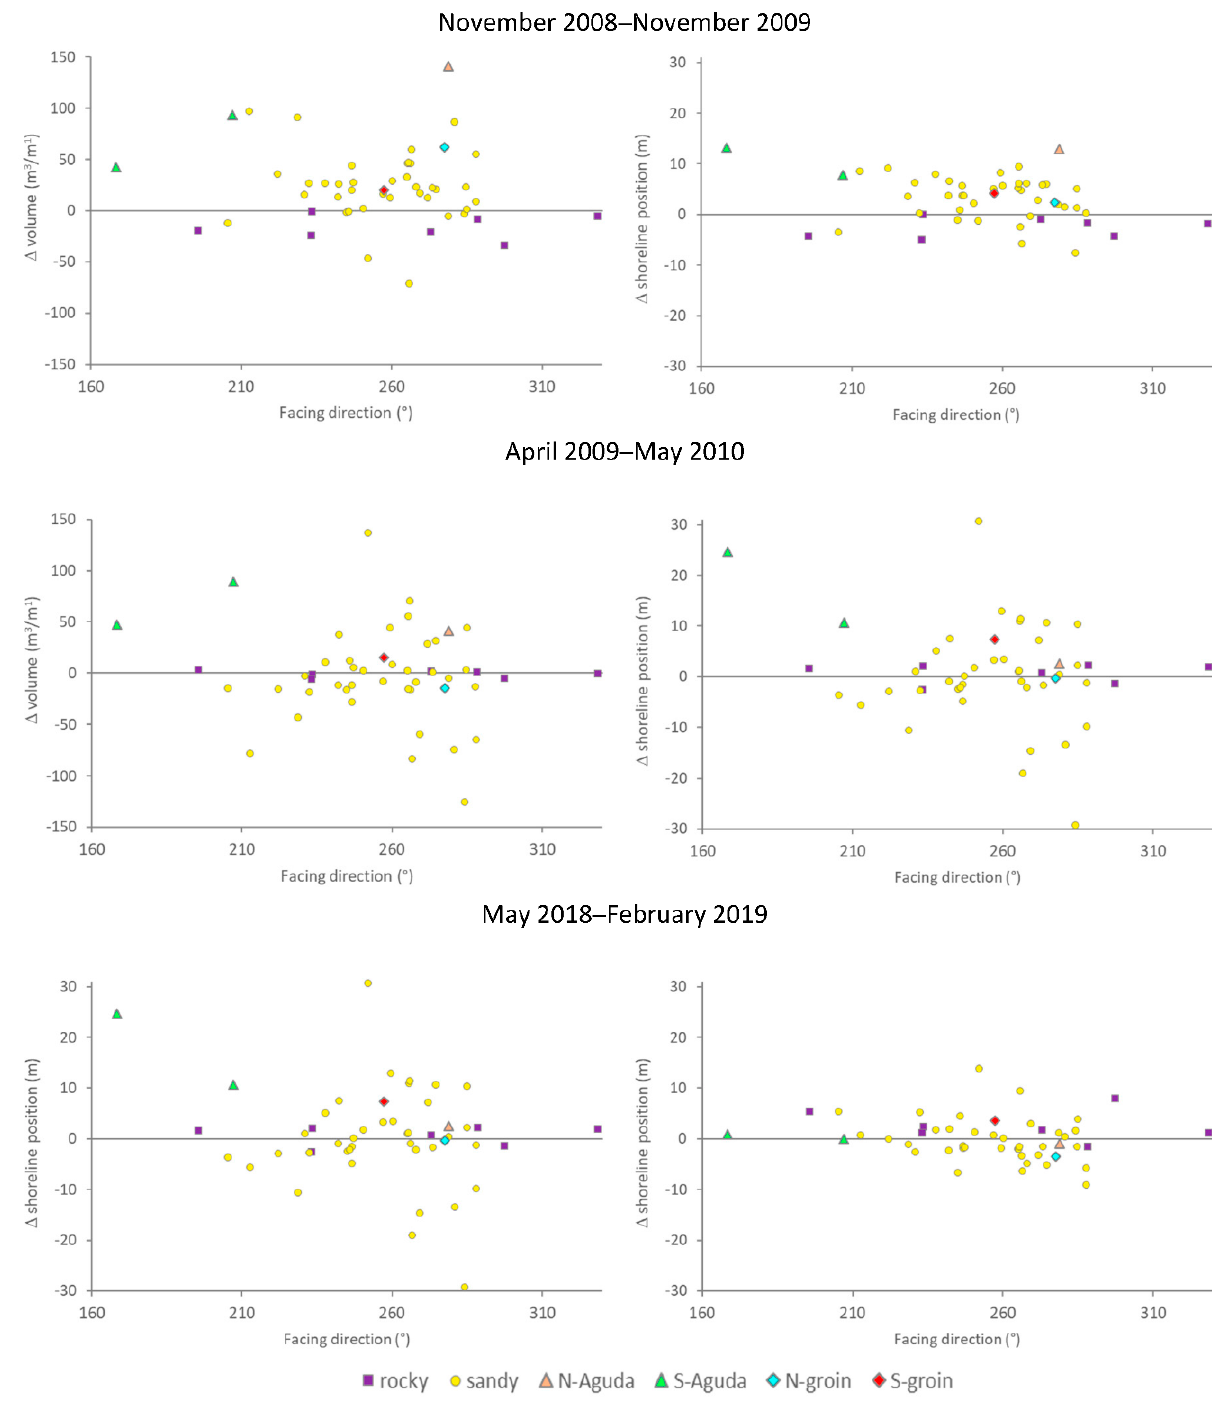
Figure 13. Yearly changes in volume and shoreline position per segment presented according to the segment orientation and marked according to the segment type or its location (N-Aguda: segment 40 north of the Aguda breakwater, S-Aguda: segments 43 and 44 south of the Aguda breakwater, N-groyne: segment 13 north of the groyne, S-groyne: segment 15 south of the groyne).